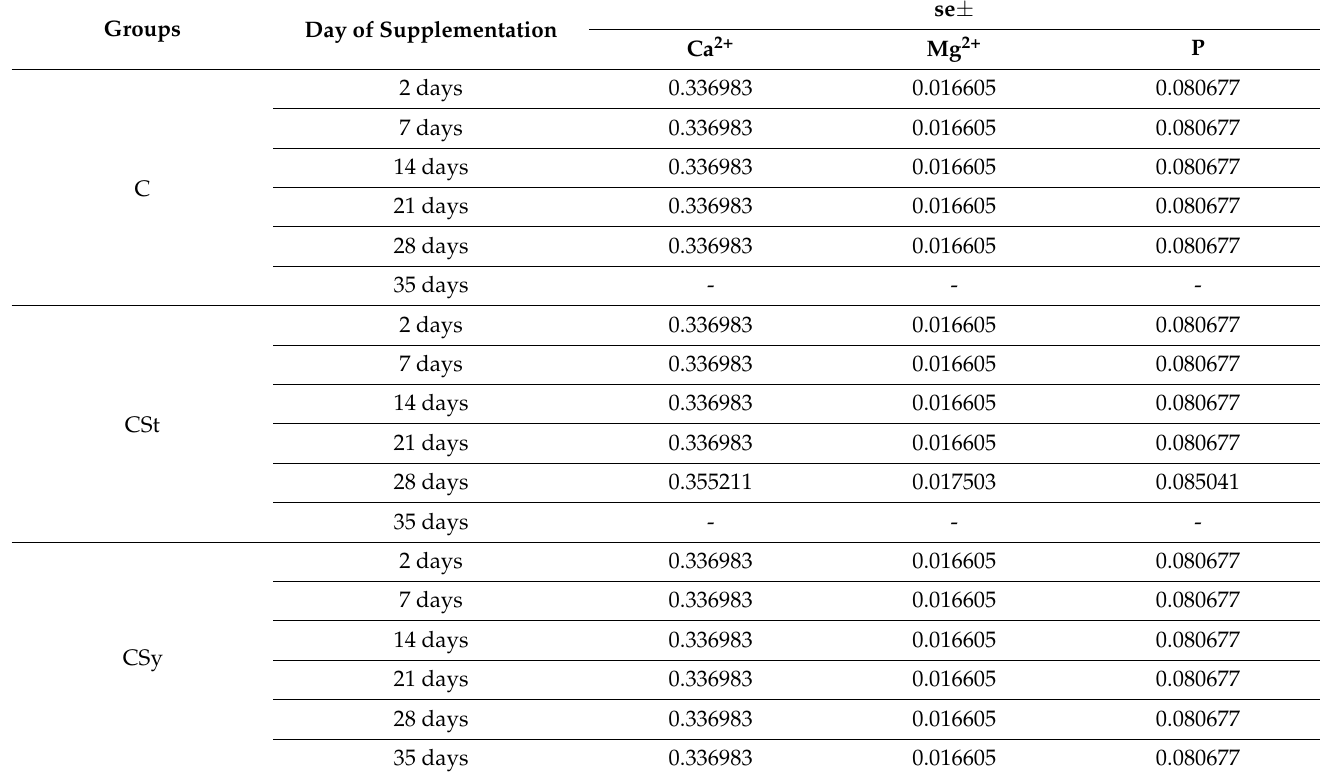
extract on strips, according to two-way